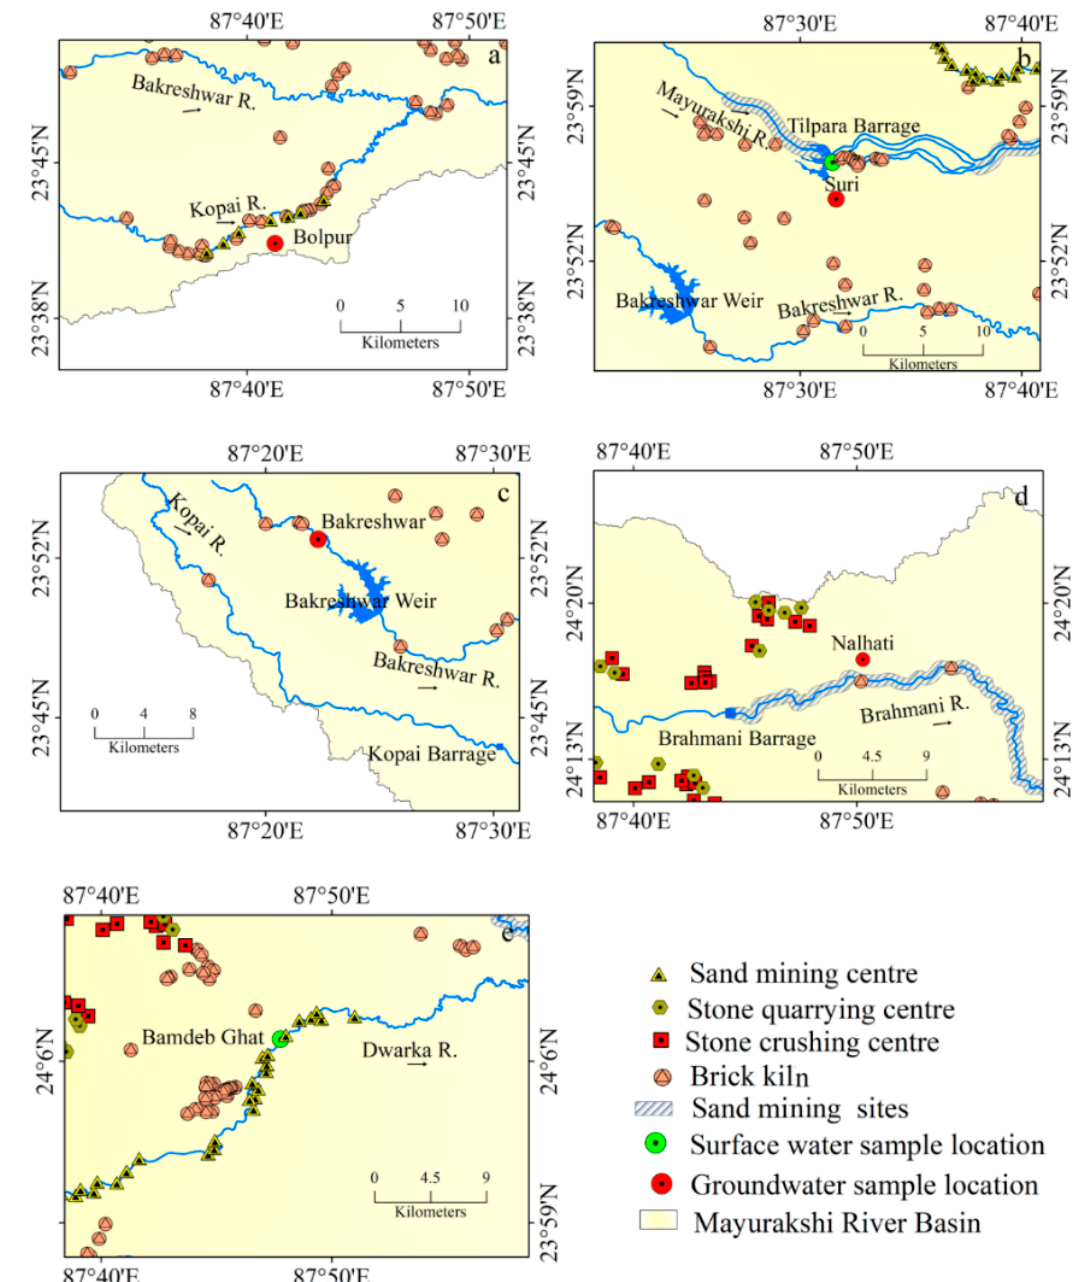
Figure 11. Anthropogenic activities around the sample location: ( a ) Bolpur, ( b ) Suri, ( c ) Bakreshwar, ( d ) Nalhati, ( e ) Bamdeb Ghat.